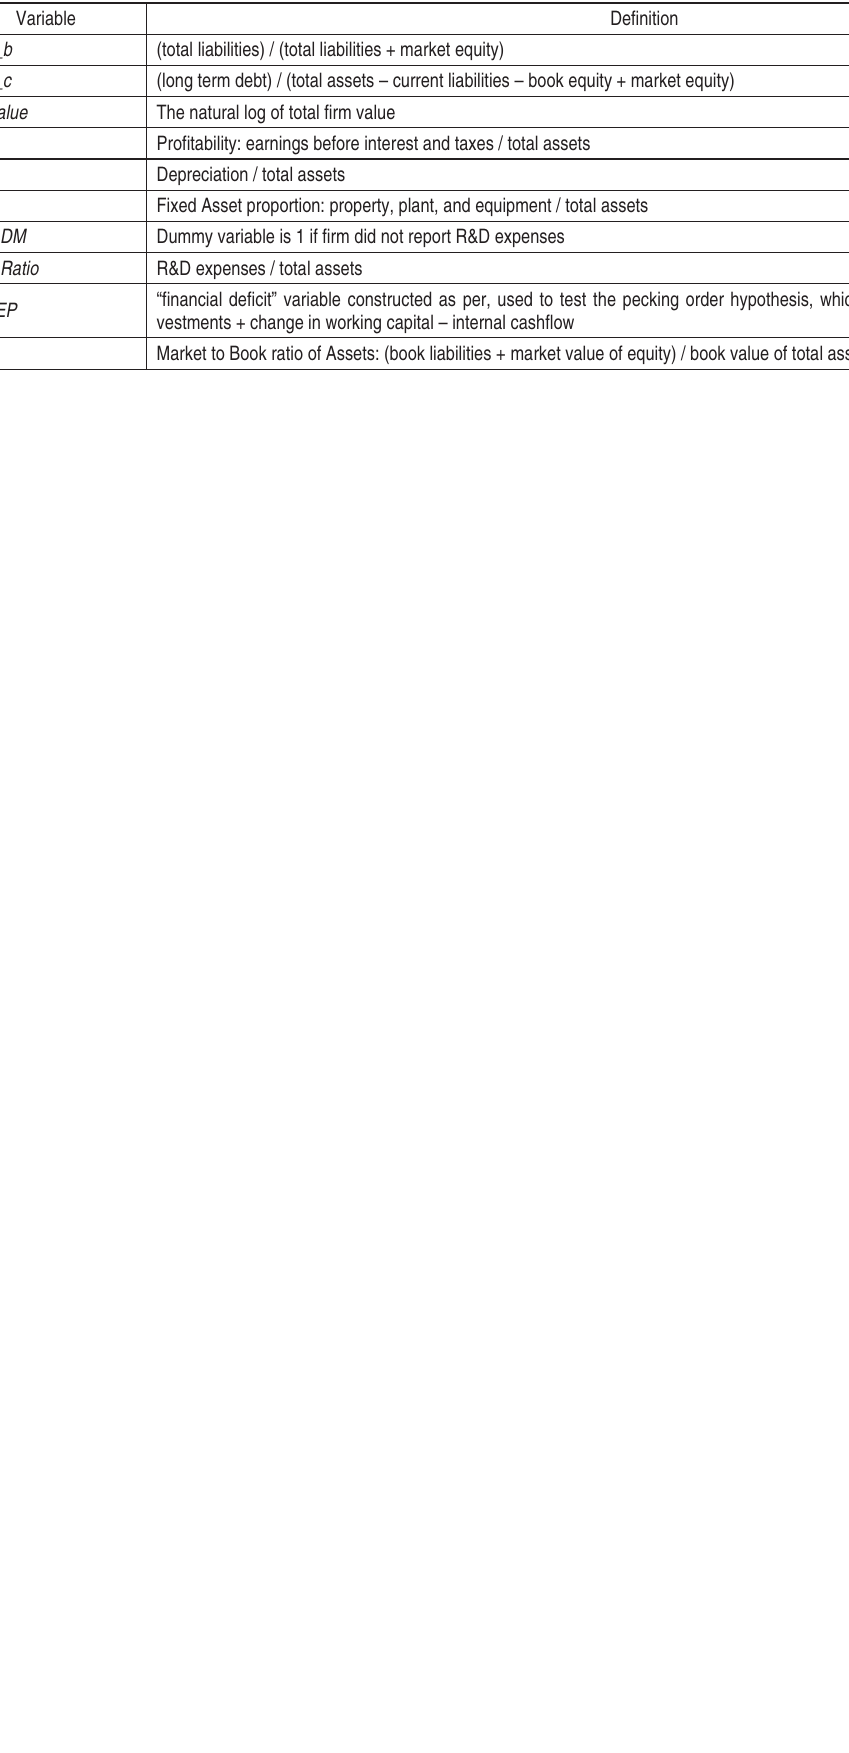
Table A1 (cont.). Variables